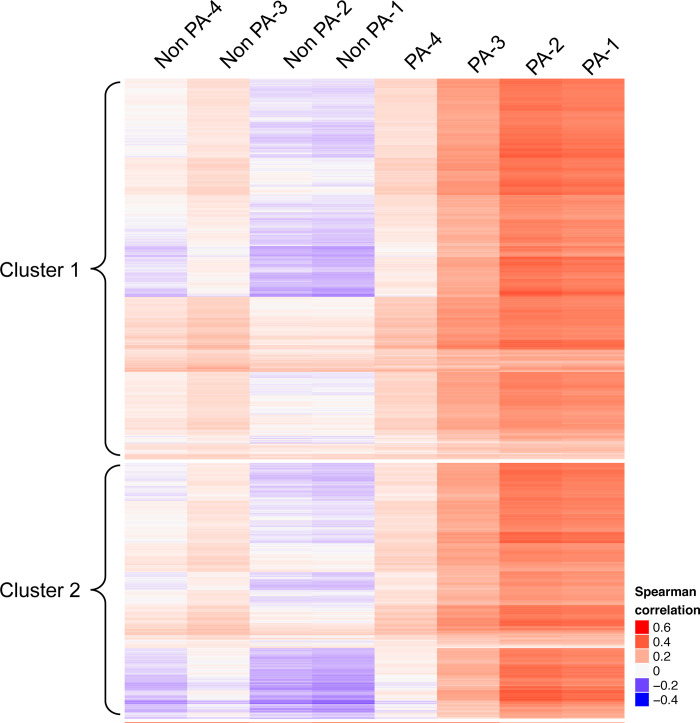
Correlation analyses of bulk RNAseq and scRNAseq data.Expression of genes in PAs (EGFP+) fractionated from Mlc1-EGFP mice and analyzed by single cell RNAseq (cell clusters 1 and 2, see Fig 2) were compared to gene expression patterns of PAs (EGFP+/DsRed+) and non-PAs (DsRed+) isolated from Mlc1-EGFP;GLAST-DsRed mice (n = 4). Note that gene expression patterns in purified PAs based on EGFP+ or EGFP+/DsRed+ expression correlate with each other, but do not correlate with non-PA expression patterns. Single cells from the scRNAseq analyses are shown along the y-axis. Heatmaps were colored using Pearson correlation coefficients between the gene expression of single cells in rows (y-axis) and expression of bulk samples (PA and non-PA samples) in columns (x-axis).